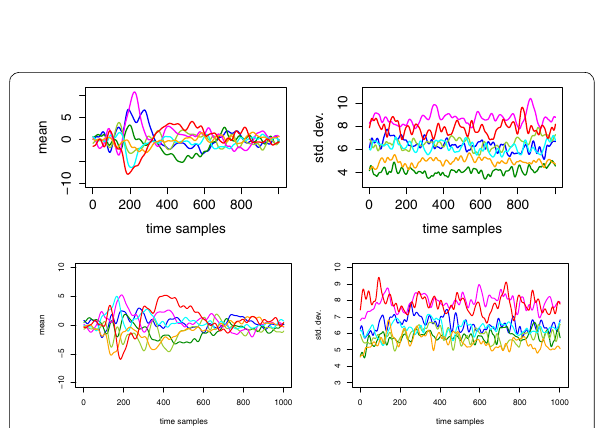
Fig. 12 Exemplary mean traces (left) and standard deviation traces (right) for the reaction of different users to the correct PIN value (Electrode P8 on top row and Electrode P7 on bottom row)